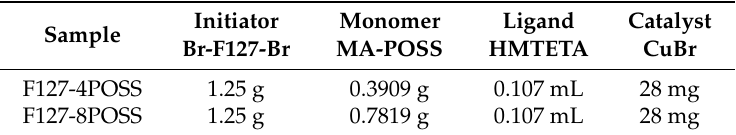
Table 1. Feed amount for synthesis of